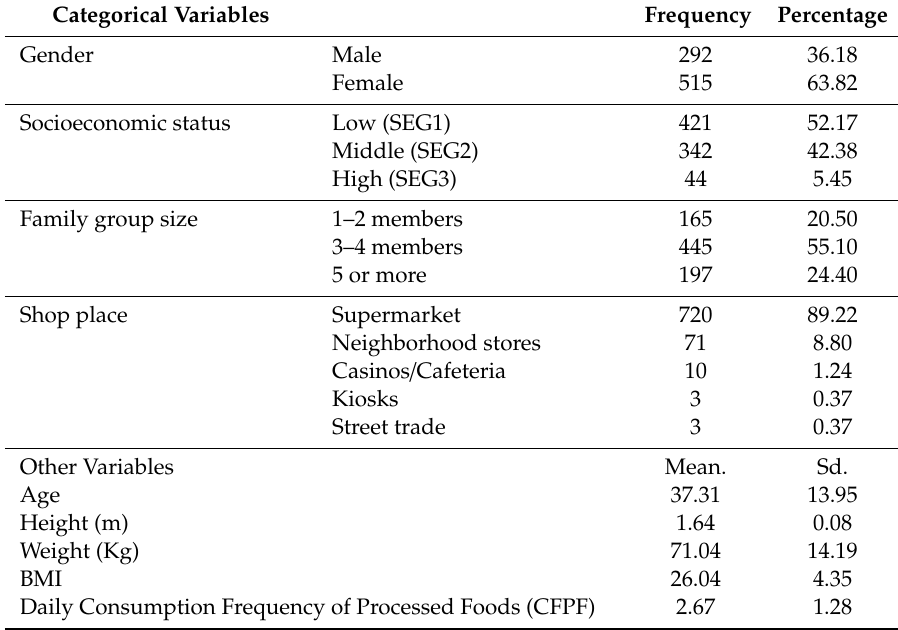
Table 1. Descriptive Statistics for Sociodemographic and Physiological